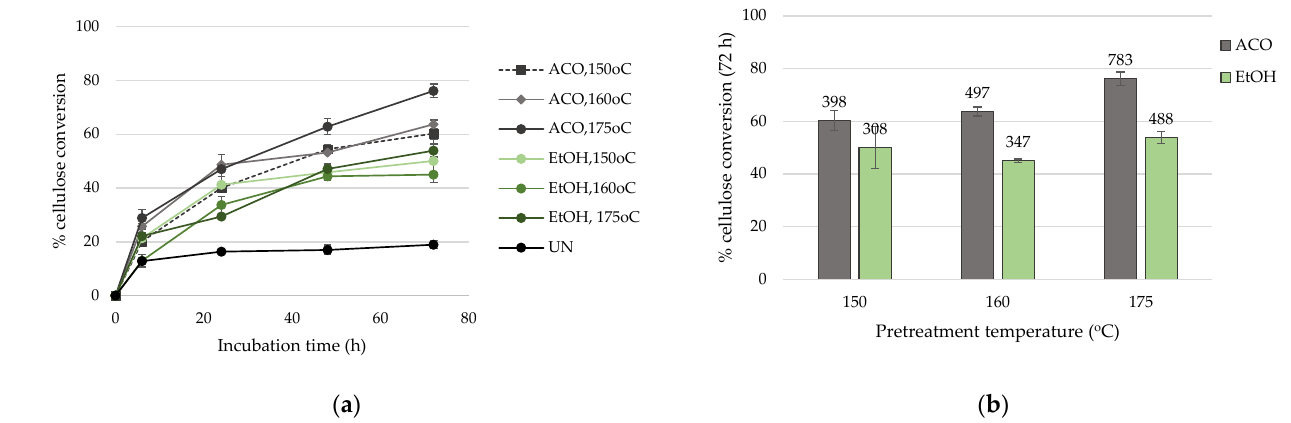
Figure 2. ( a ) Time course of hydrolysis (solid fraction) as function of incubation time and (b) effect of temperature and solvent on the % cellulose conversion. Labels in ( b ) represent the mg of glucose/g of pretreated biomass.